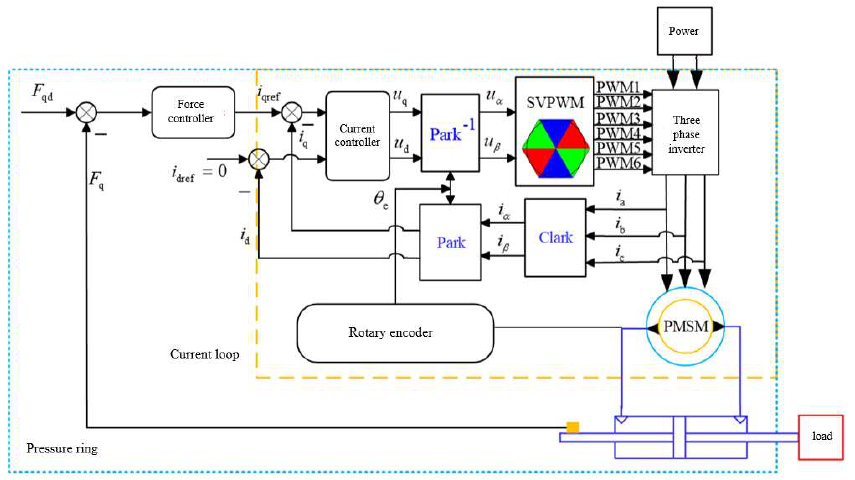
Figure 5. Double closed-loop diagram of force control of the pump control system.